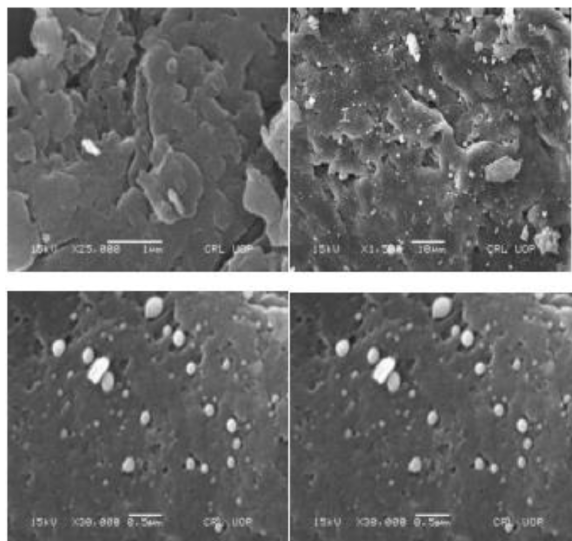
Figure 9: The SEM image of palladium nanoparticles at different angles.